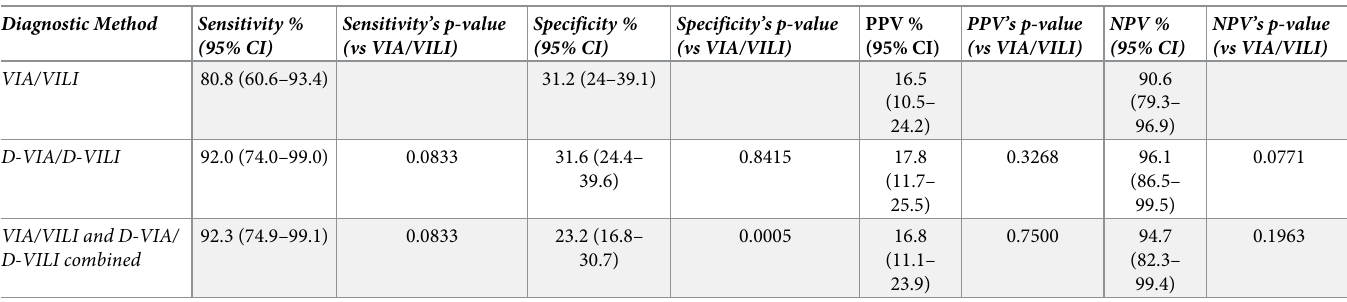
Table 3. Sensitivity, specificity, PPV and NPV of each diagnostic